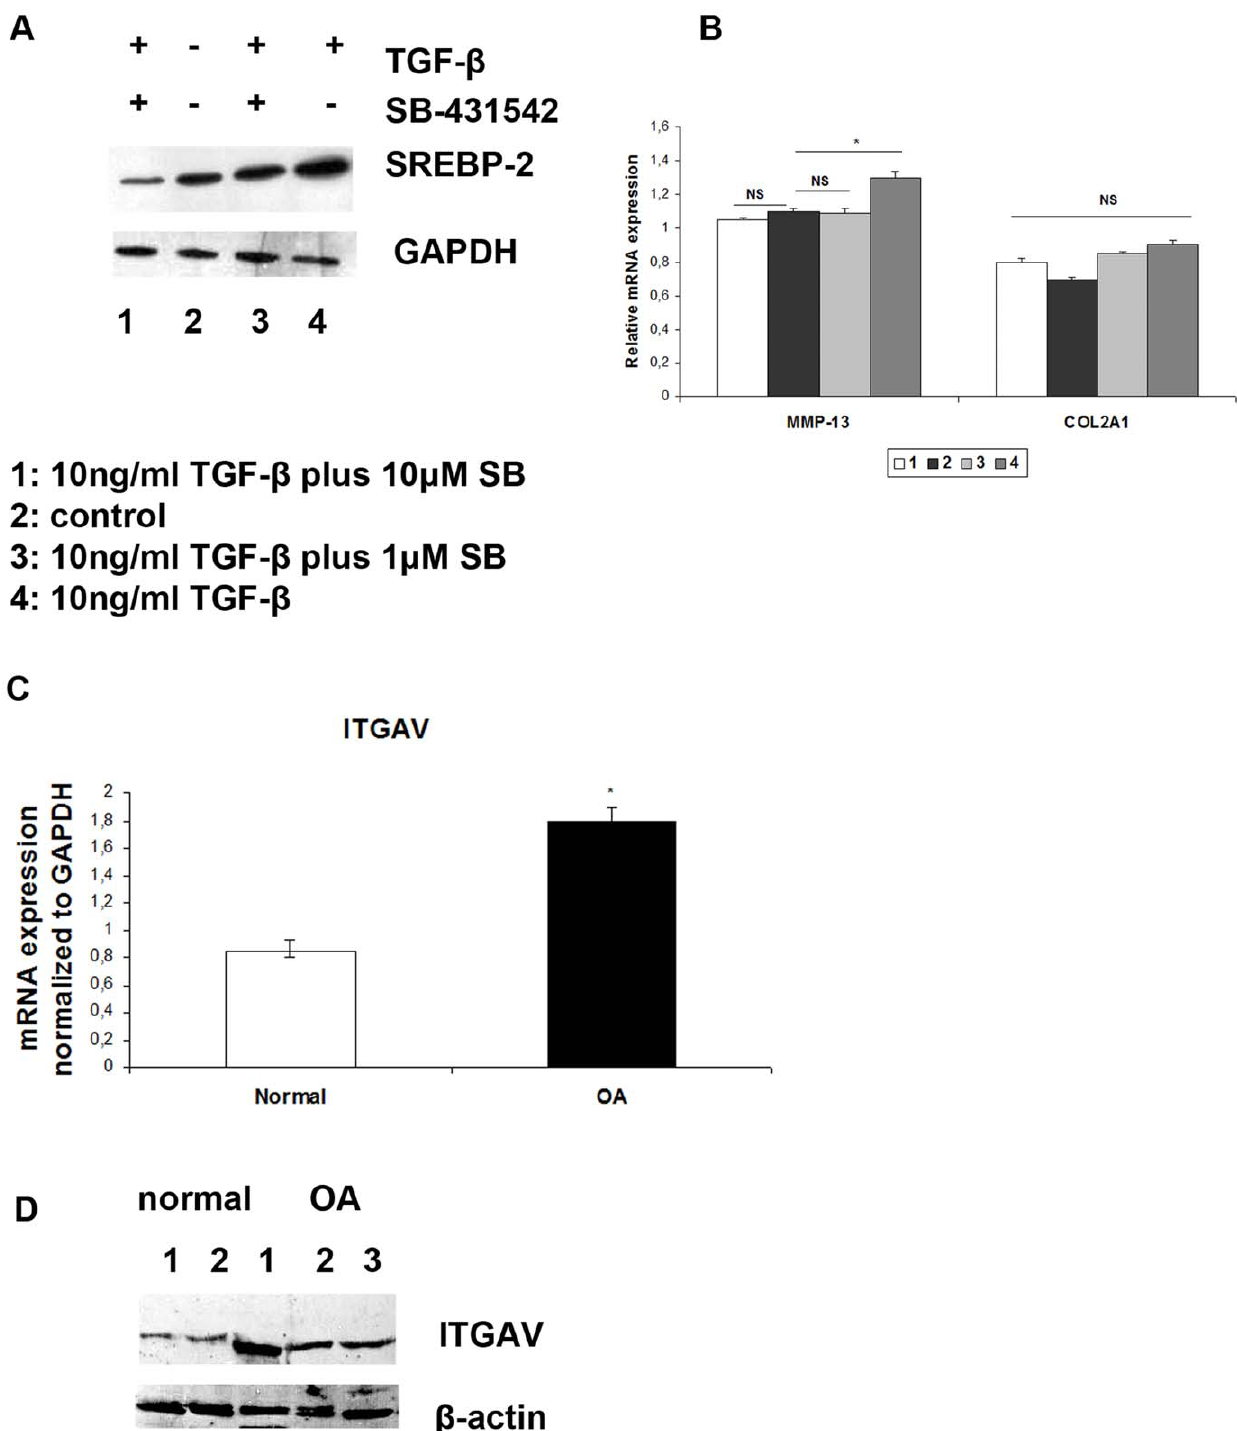
Figure 4. Effect of TGF- b receptor inhibitor (SB-431542) on SREBP-2 expression and ITGAV expression in normal and osteoarthritic chondrocytes. ( A ) Western blot showing SREBP-2 protein expression levels in normal chondrocytes treated with 10 ng/ml TGF- b , 10 ng/ml TGF- b plus 1 m M SB-431542, and 10 ng/ml TGF- b plus 10 m M SB-431542 for 6 h. GAPDH was used as loading control. ( B ) MMP-13 and COL2A1 mRNA expression levels in normal chondrocytes treated with 10 ng/ml TGF- b , 10 ng/ml TGF- b plus 1 m M SB-431542, and 10 ng/ml TGF- b plus 10 m M SB- 431542 for 6 h, normalized to GAPDH. *p , 0.05, NS: non significant ( C ) ITGAV mRNA expression in normal and osteoarthritic chondrocytes. GAPDH was used for normalization of the Real Time PCR data. All experiments were performed in duplicate. Data are expressed as mean. *p , 0.05 ( D ) A representative western blot showing increased protein levels of ITGAV in osteoarthritic chondrocytes compared to normal, where b -actin was used as loading control.